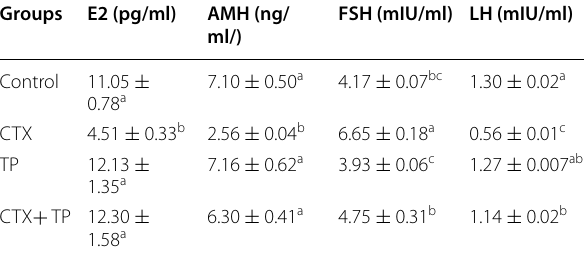
Each value represents mean SE ( n 8). a, b, ab, and c denote significant ± = difference from normal-control, CTX induced POF, P. columbines extract control and POF P. columbinus (before and after) groups, respectively, p < 0.05 (one- + way ANOVA followed by post hoc Tukey)